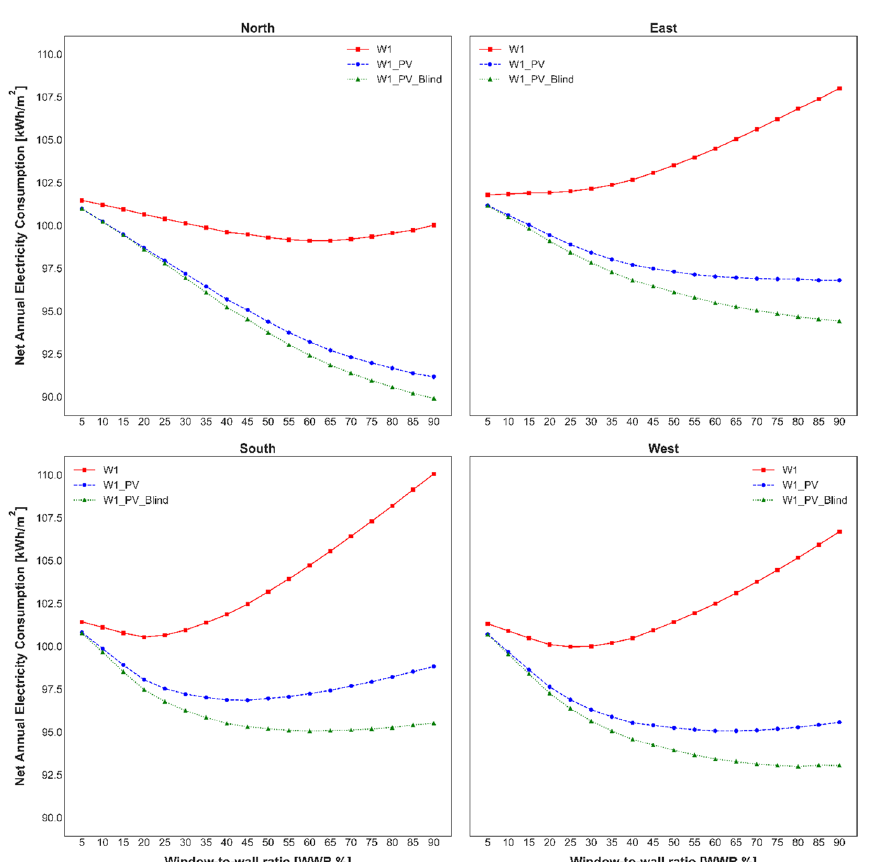
Fig. 7 Net annual electricity consumption of STPV with dynamic